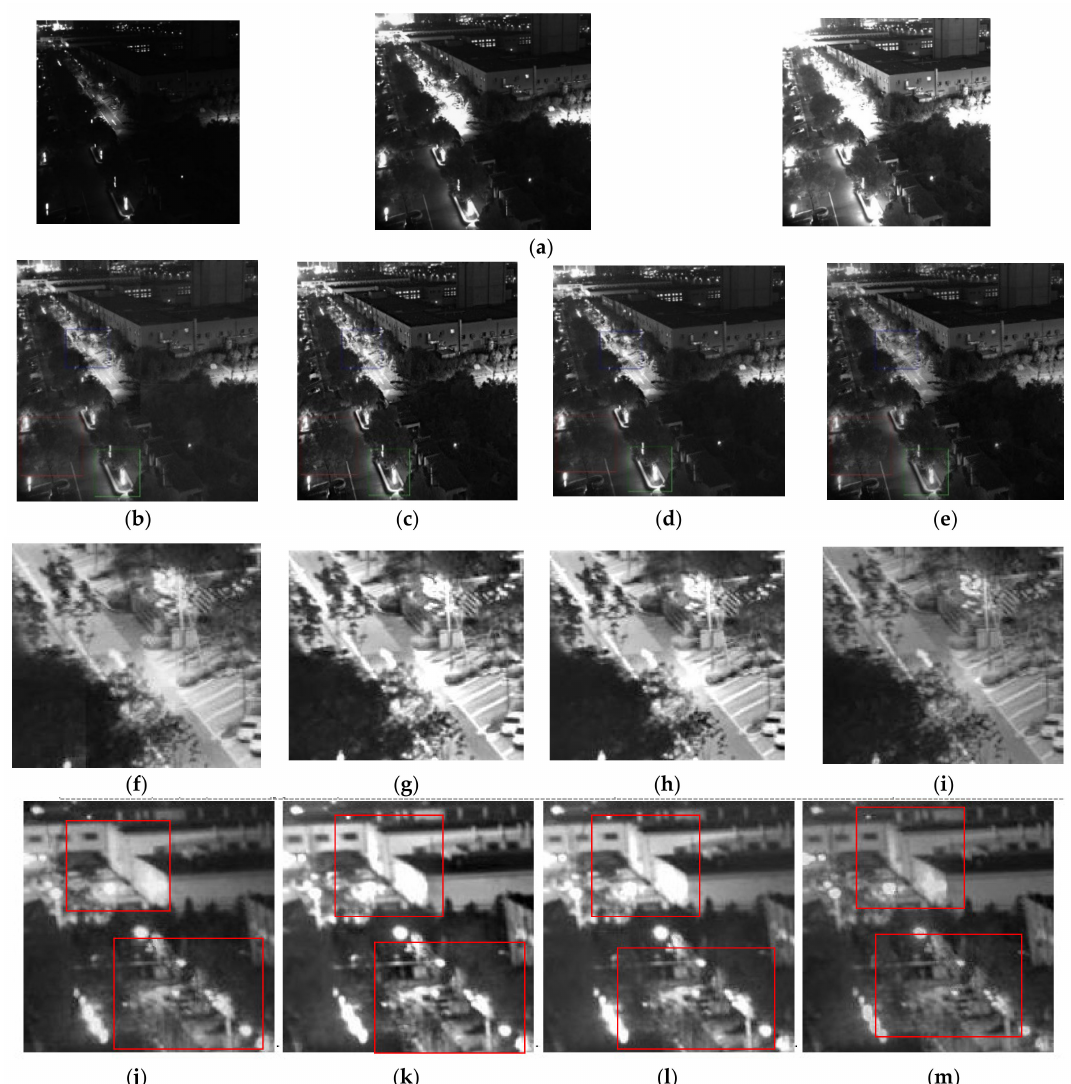
Figure 8. Comparison of different methods on the buildings. ( a ) Source image sequence. ( b ) The fusion image of [16]. ( c ) The fusion image of [29]. ( d ) The fusion image of [15]. ( e ) The fusion image of our method. ( f ) The local image by [16]. ( g ) The local image by [29]. ( h ) The local image by [15]. ( i ) The local image by our method. ( j ) The local image by [16]. ( k ) The local image by [29]. ( l ) The local image by [15]. ( m ) The local image by our method. The original low dynamic images are shown in Figure 9. Figure 10 shows the MEF fusion of computer screen images taken in the door. Overall, all four methods have restored some desk information and obtained computer screen information, as shown in Figure 10e–h. Moreover, local images are shown in Figure 10a–d. As shown from the local images, we can see that for the icon at the top left corner and the picture at the lower right corner of the computer in the highlighted area, the proposed method maintains better details and contour information, and the grayscale distribution of our method is natural at the same time. However, other images bring gray distortion to different